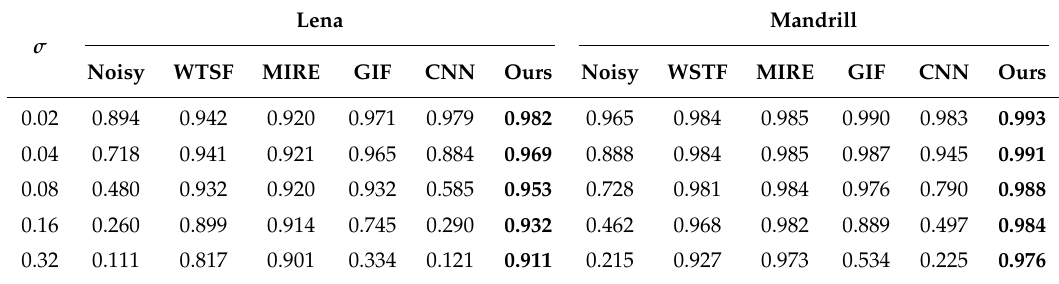
Table 3. Structure similarity (SSIM) results for Lena and Mandrill.